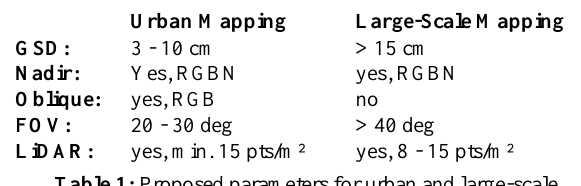
Table 1: Proposed parameters for urban and large-scale mapping sensors